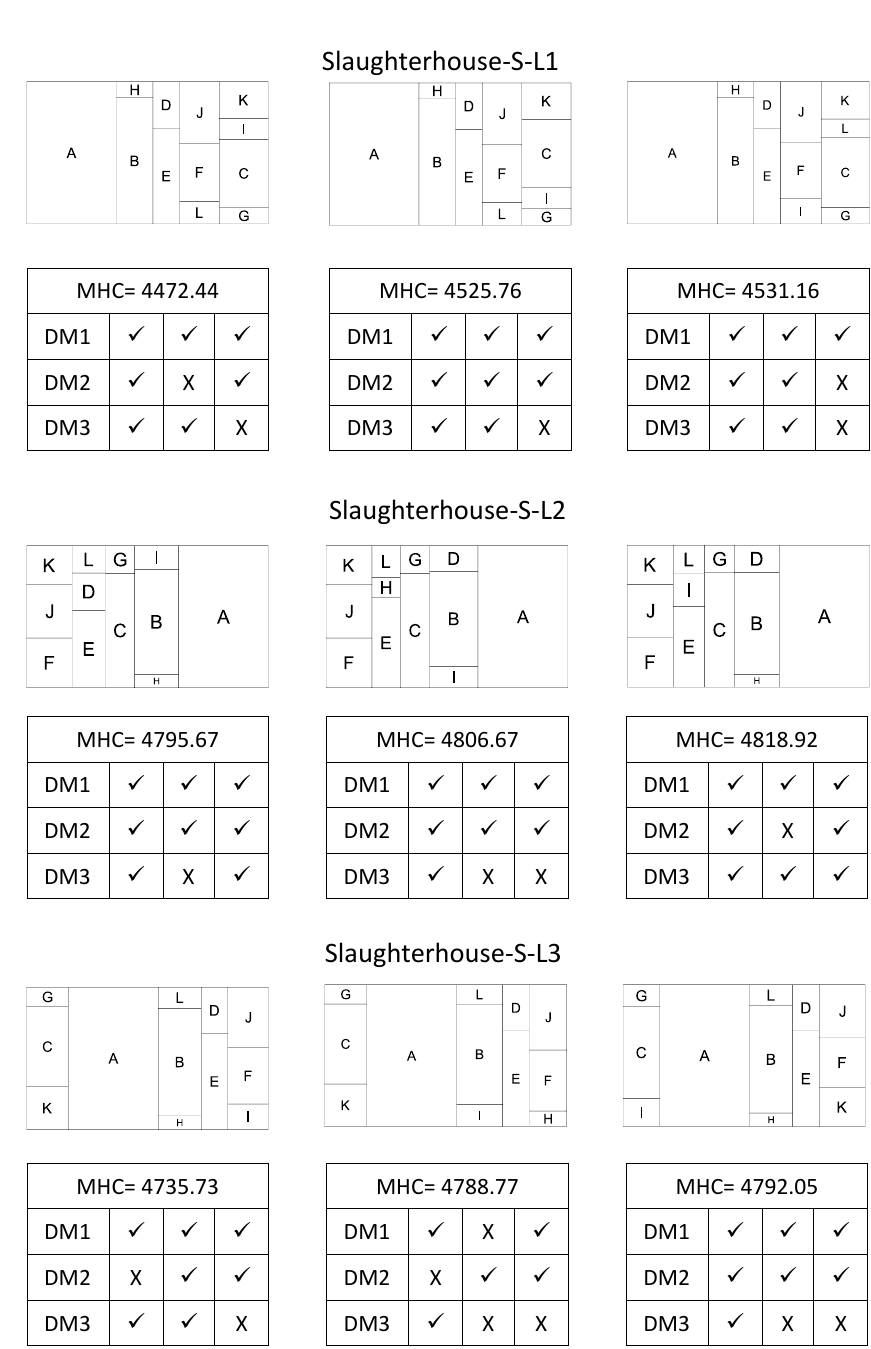
Figure 9. Best solutions found in Sequential launch 1 to 3 of Slaughterhouse